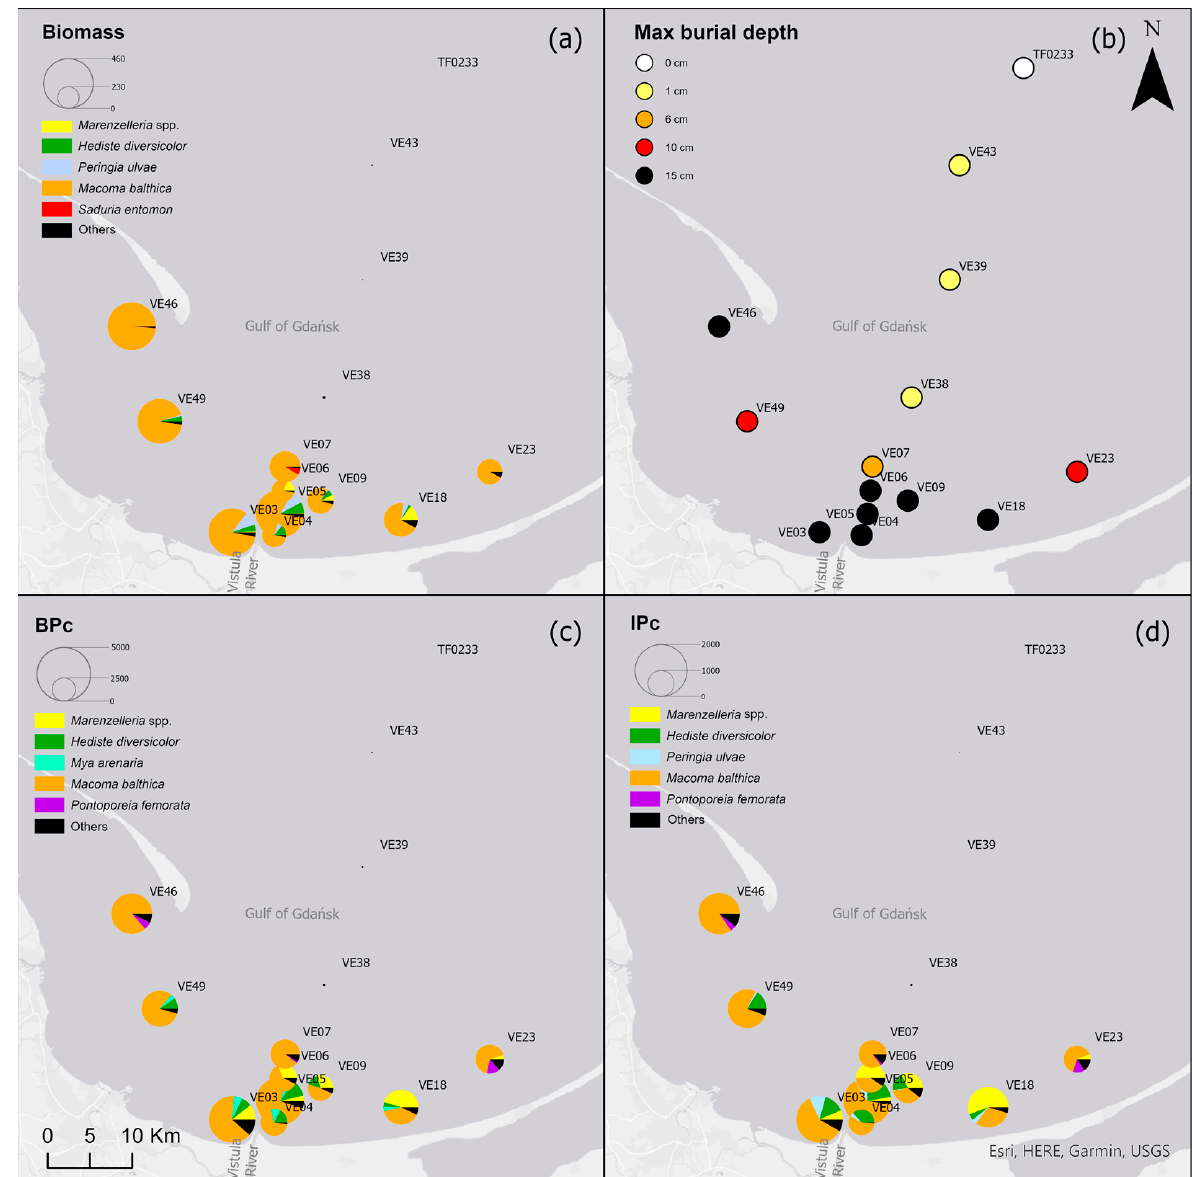
Figure 5. ( a ) Biomass [g·m − 2 ]; ( b ) maximum burial depth of organisms [cm]; ( c ) bioturbation potential index (BP C ) and ( d ) bioirrigation potential index (IP C ), and the proportion of taxa in the values of each parameter in the Gulf of Gda ń sk.